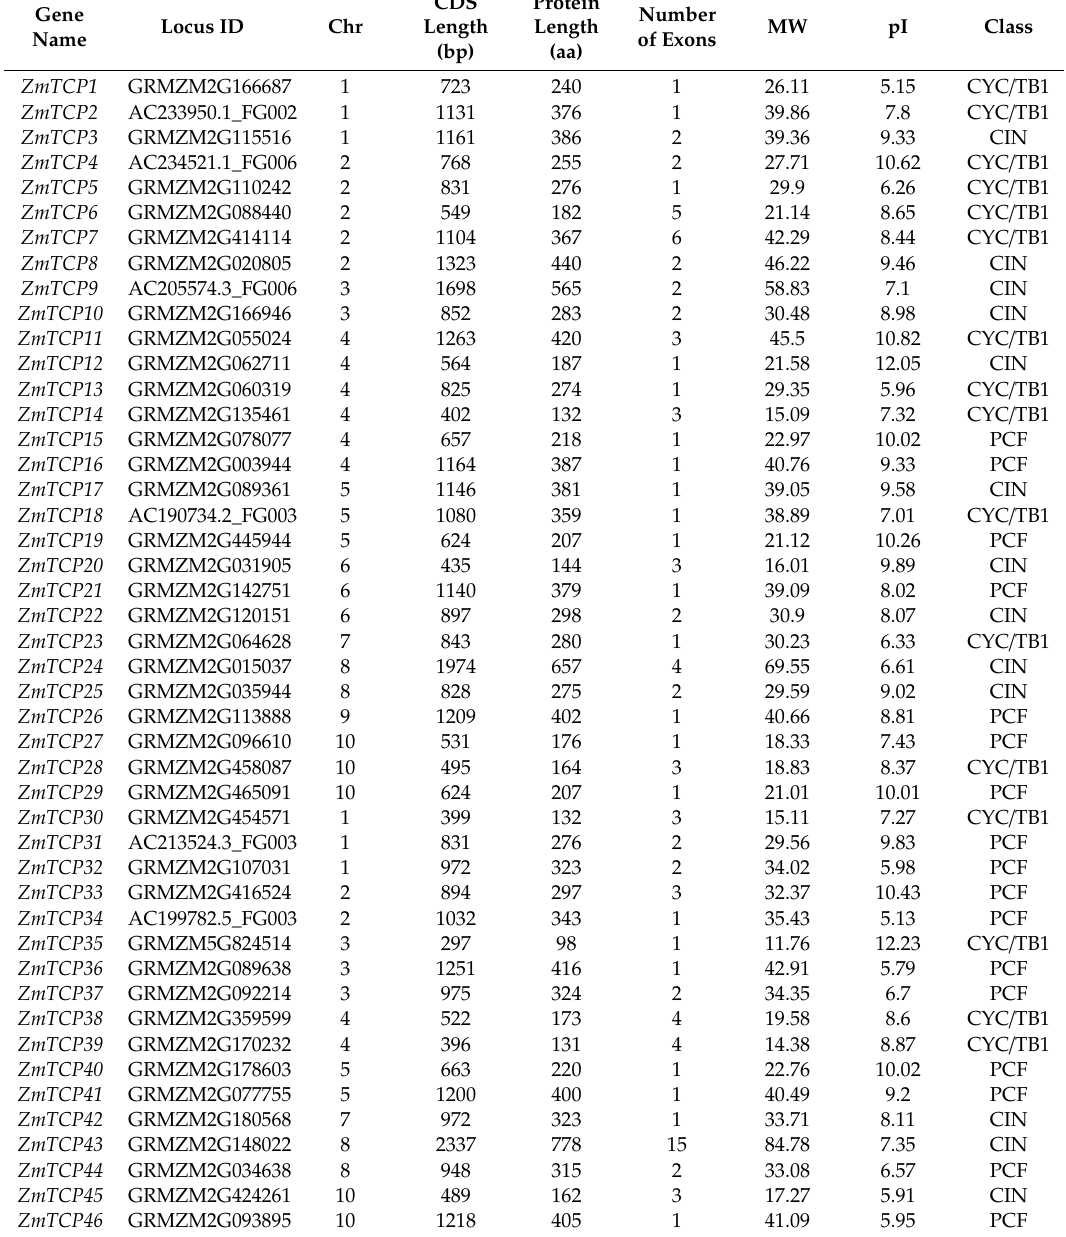
Table 1. Detailed information for 46 ZmTCP genes in the Zea mays L.